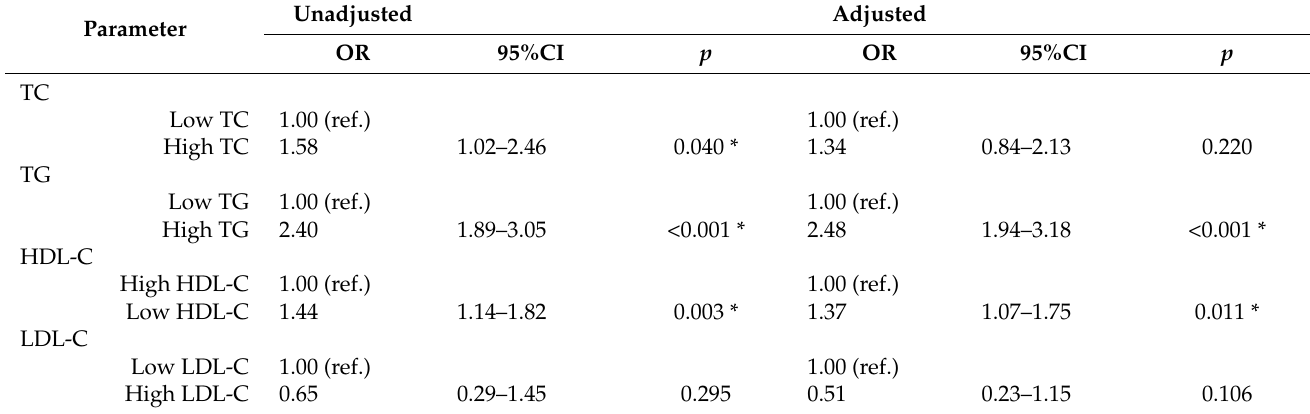
Table 2. OR and 95%CI for the risk of T2DM according to the levels of serum lipids.